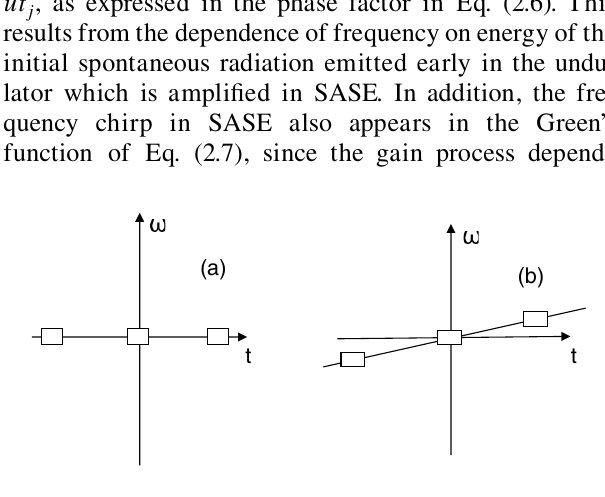
FIG. 2. Time-frequency phase space for (a) spontaneous ra- diation with no electron energy chirp and (b) spontaneous radiation with positive electron energy chirp. The little rectan- gles correspond to the wave packets emitted by three represen- tative